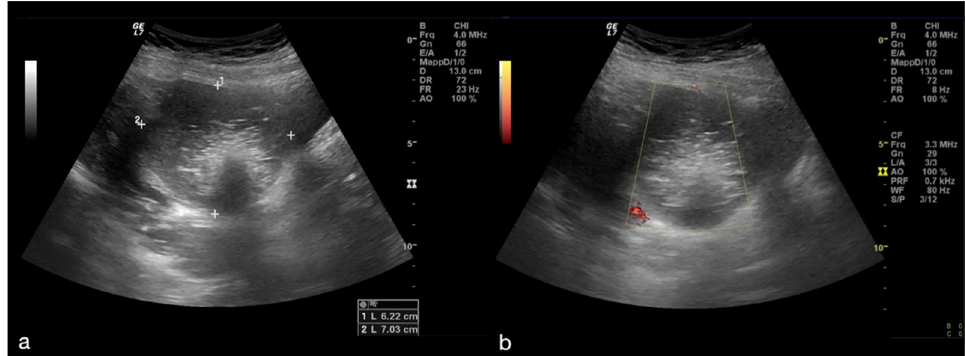
Figure 1. Adnexal torsion of giant mature cystic right teratoma. Axial TSA-US image ( a ) shows a mostly echogenic mass (caliper) with some sound attenuation. On power Doppler ( b ) no adnexal vascularization is detected.